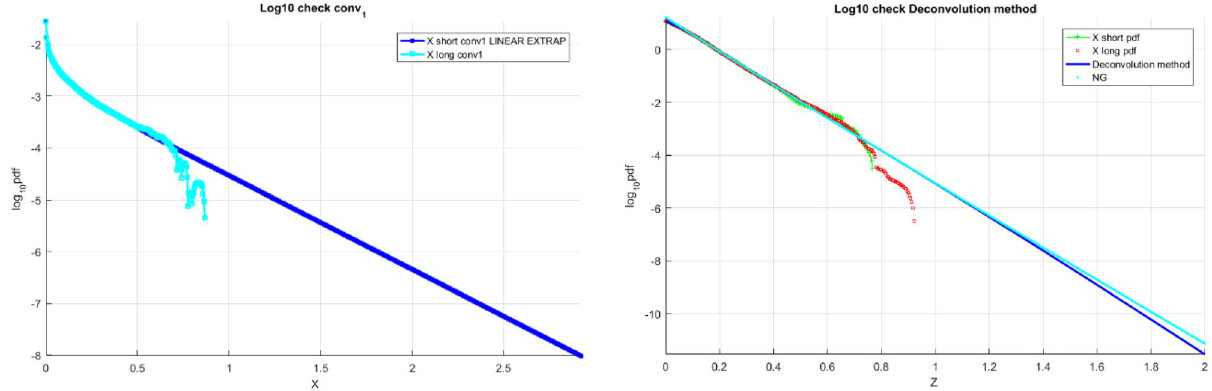
Figure 3. TEU vessel data. Left: scaled f X 1 tail on the decimal log scale for the «shorter» data (cyan), linearly extrapolated (dark blue). Right: unscaled raw «shorter» data (green) f X tail on the decimal log scale, extrapolated by the deconvolution method (dark blue), along with «longer» raw data (red) and NG extrapolation (cyan).